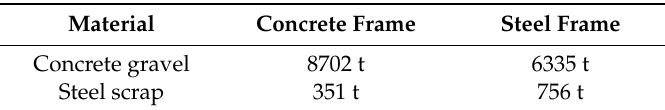
Table 7. End-of-life